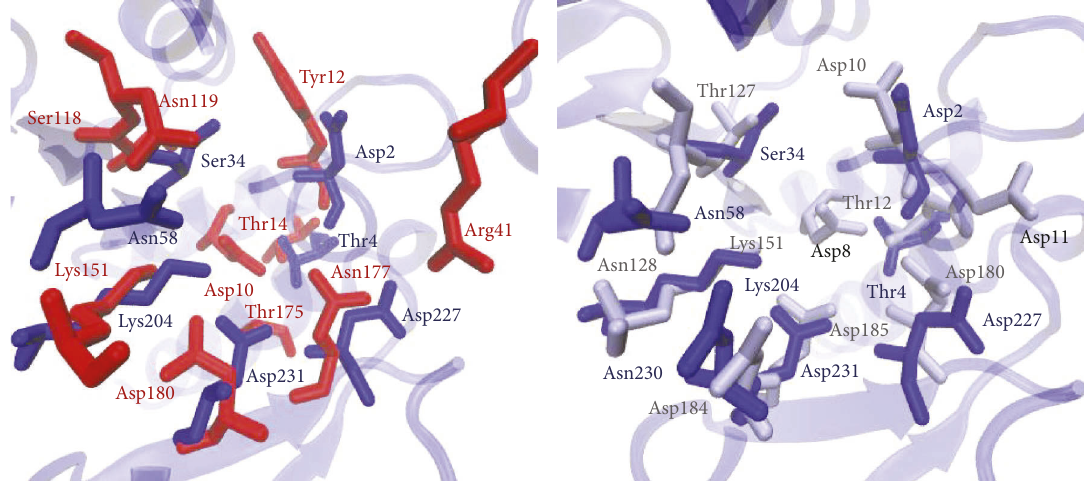
Figure 3: Active site alignment of Bcfd1 (blue) with L-DEX YL (red) from Pseudomonas sp. YL and ps-2-HAD (gray) from P. syringae . The active site of Bcfd1 is more similar to the active site of ps-2-HAD with more aspartate residues than L-DEX YL which is predicted to be involved in the catalytic reaction